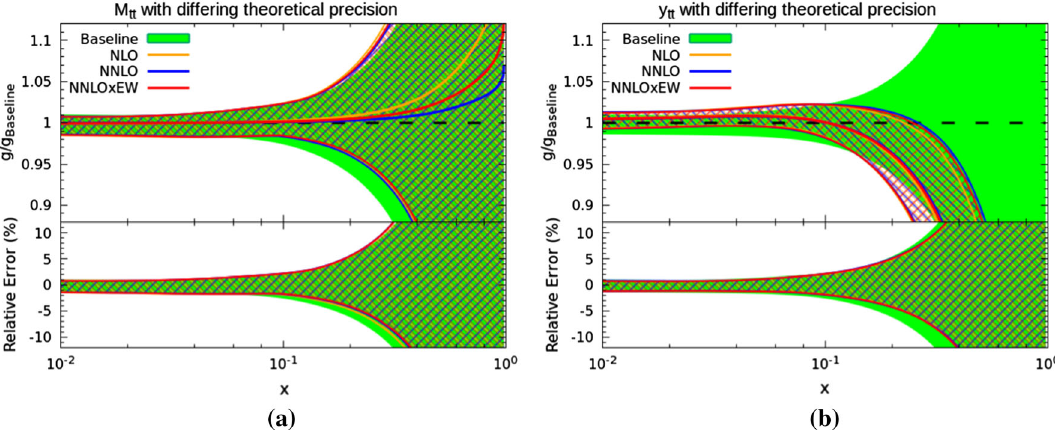
Fig. 7 Impact of the ATLAS 8 TeV lepton + jet data on the gluon PDF, for different levels of precision in the theoretical prediction for the top quark pair production cross section, when fitting the M tt (left) and y tt (right)